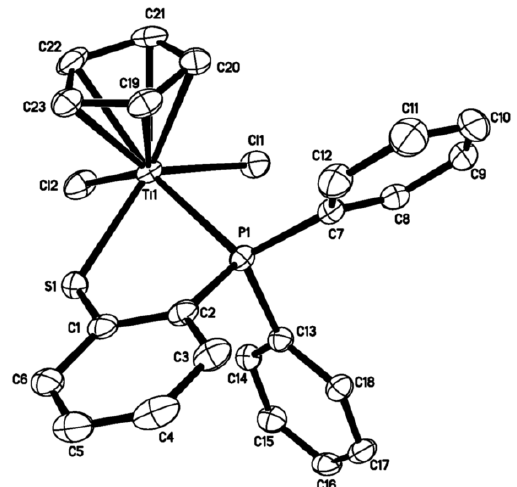
Figure 1. Molecular structure of complex 2a with thermal ellipsoids at 30% probability level. The hydrogen atoms and the solvent molecule are omitted for